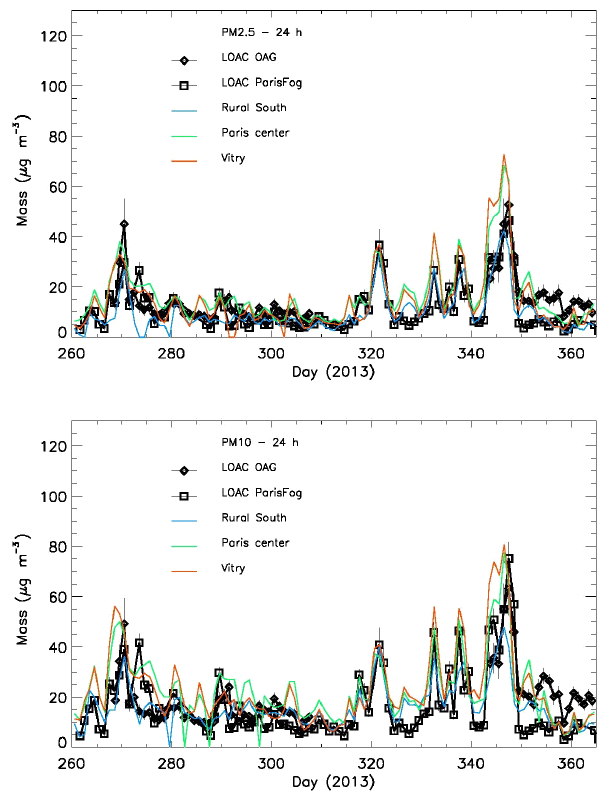
Figure 23. PM 2 . 5 (upper panel) and PM 10 (lower panel) LOAC mass concentrations measurements in 2014 at the OAG (south-west of Paris) and comparison with reference TEOM data from the Air- parif air quality monitoring